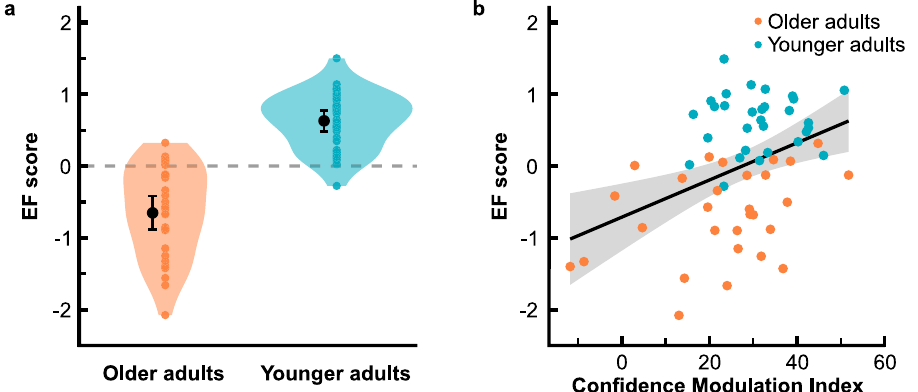
Figure 6. Cognitive control capacities and metacognitive sensitivity. ( a ) EF score as a function of age group; EF scores provide a combined measure for cognitive control capacities averaging z -scores from DSST, TMT-B, VST- C, and LPS-3; coloured dots illustrate individual data and black dots represent the mean; shaded areas display 95% of the data distribution smoothed by a kernel density function. Error bars give 95% confidence intervals. ( b ) EF scores as a function of CMIs; data for older and younger adults are plotted in different colours; shaded area gives 95% confidence interval.